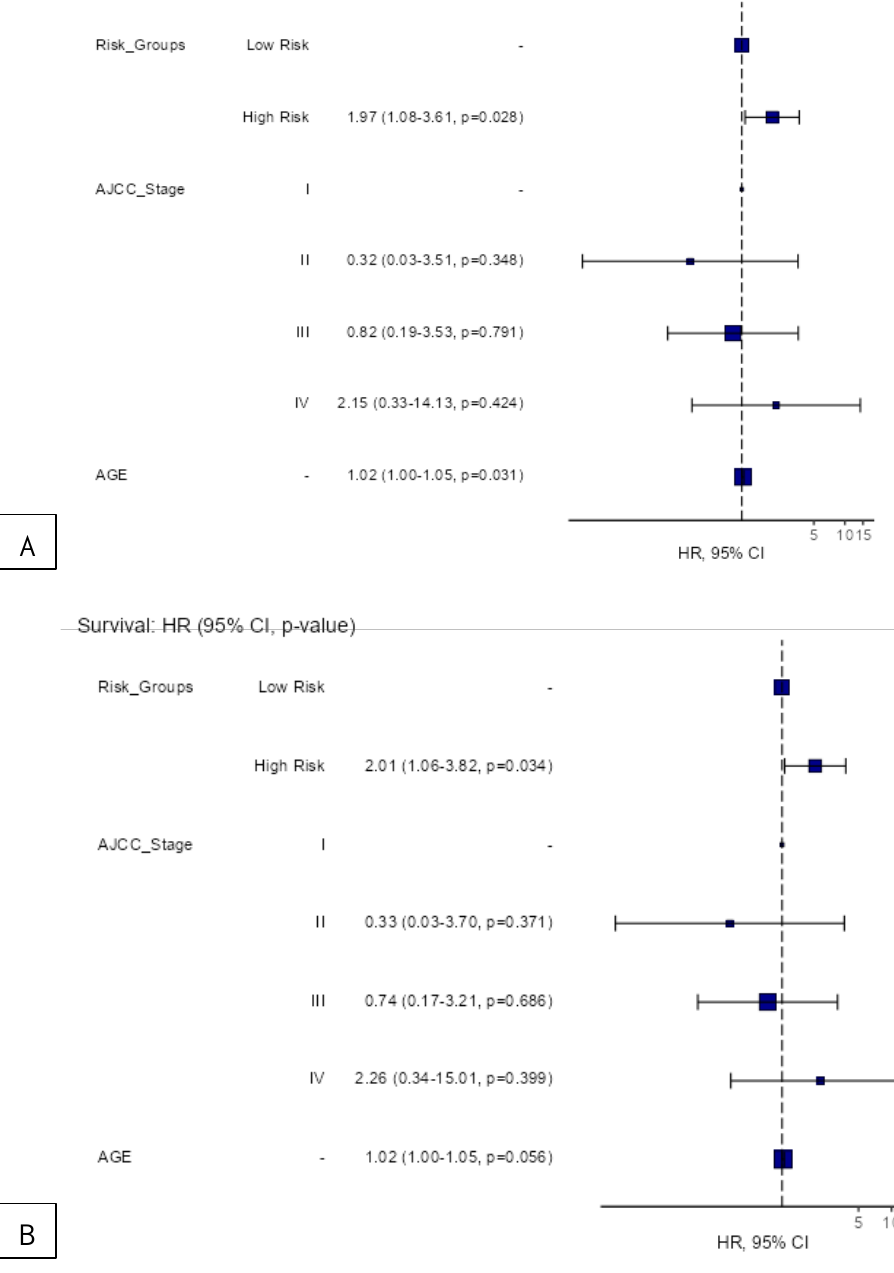
Figure 5. Hazard regression plots for multivariable cox proportional hazards regression analyses of the 12-gene signature risk score and its survival prognostic performance with ( A ) OS in TCGA melanoma patients with RLN tissue samples (n = 116), and ( B ) OS in the total cohort (n = 426).